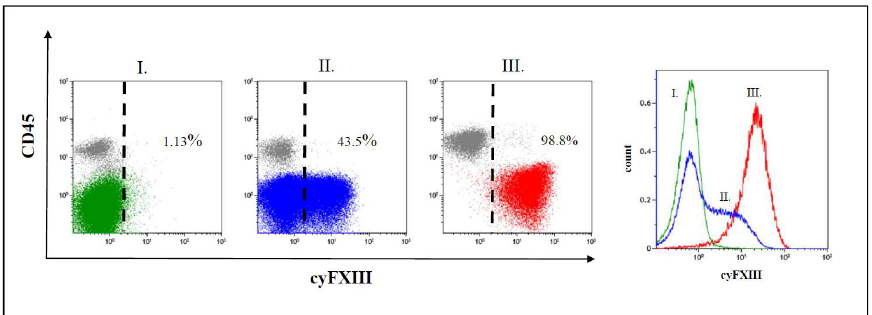
Figure 1. Representative dot plots and histograms of leukemic lymphoblasts. There are three different patterns of cytoplasmic FXIII-A expression in terms of positivity of leukemic lymphoblasts (CD45 negative population): ( I ) negative expression pattern below 20%, ( II ) dim positive expression pattern between 20% and 79%, and ( III ) bright positive expression pattern ≥ 80% of leukemic lymphoblasts with an FXIII-A staining exceeding the intensity of negative controls, i.e., residual normal lymphocytes(grey). BasedonFXIII-Aexpressionintensityofnormalresiduallymphocytes, thethreshold of positivity is marked by the dashed line on the respective dot-plots. Percentages are referring to lymphoblasts. The intensity of the FXIII-A expression increased continuously, as the histogram of lymphoblasts with dim expression pattern shows (indicated by blue colour), which excludes the existence of a distinct FXIII-A negative (green colour) and a FXIII-A bright (red colour) subpopulation. In 36 patients, FXIII-A expression was evaluated in parallel at diagnosis and in the day 15 BM lymphoblastsbelow0.1%couldnotbeestimatedduetothecytoplasmicexpressionofFXIII-A.Thepercentage of FXIII-A positive leukemic lymphoblasts of patients with Flow Medium- risk (FMR) and Flow